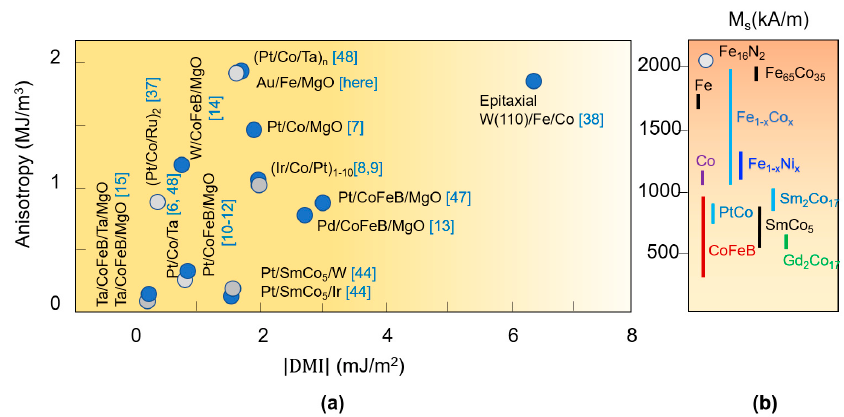
Figure 29. Selected data from the literature concerning ( a ) PMA and DMI and ( b ) saturation mag- netization M s values, fitted within the parameters range used in our micromagnetic calculations. When only the surface contribution to the PMA ( K s ) was available, the anisotropy K u has been calculated considering a ferromagnetic thickness layer of t = 1 nm: K u = K s /t; when the anisotropy field B k = µ o H k (T) was available for a layer with given M s (A/m), K u (J/m 3 ) was calculated as K u = M s H k /2